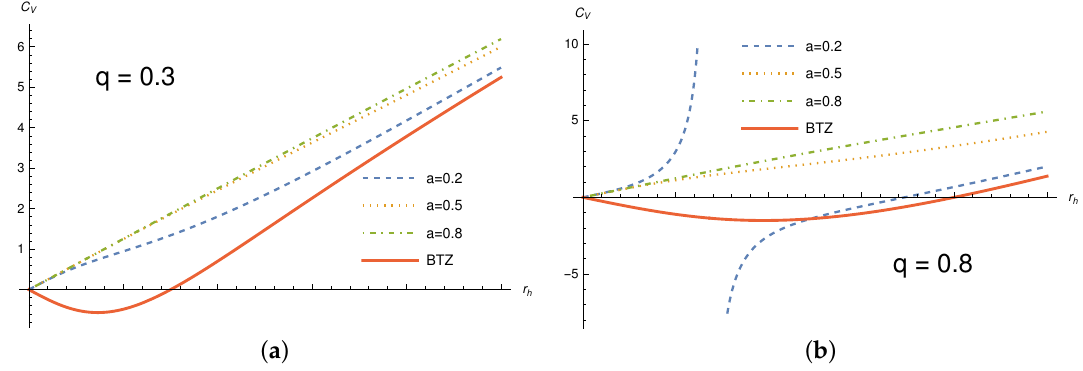
Figure 8. Plot of the heat capacity for the Simpson–Visser charged BTZ black hole. We used for this plot l = 0.5. ( a ) stands for q = 0.3 and ( b ) stands for q = 0.8.